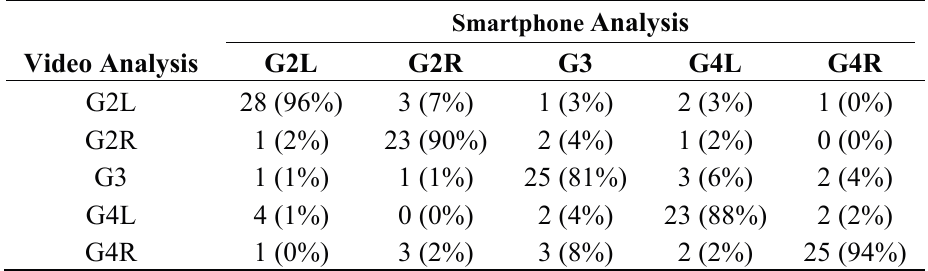
Table 1. The confusion matrix (n, %) for the gears employed during XC ski skating as identified by video analysis versus the smartphone application (mean value, n =